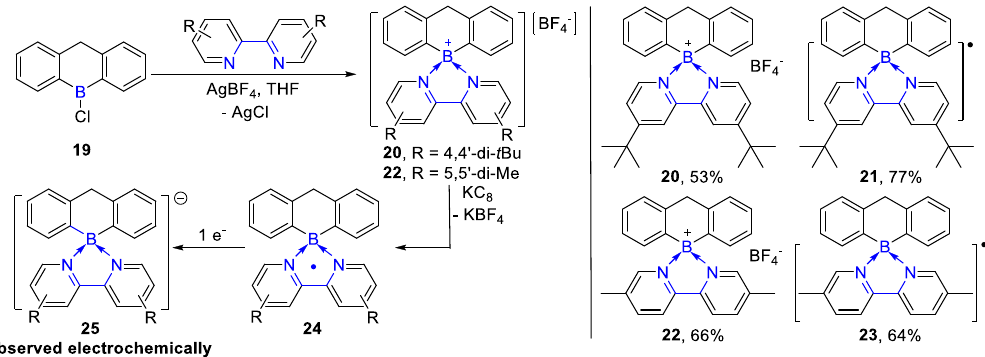
Scheme 5. Reactions of bipyridine with 5-chloro-5,10-dihydrodibenzo[b,e]borinine